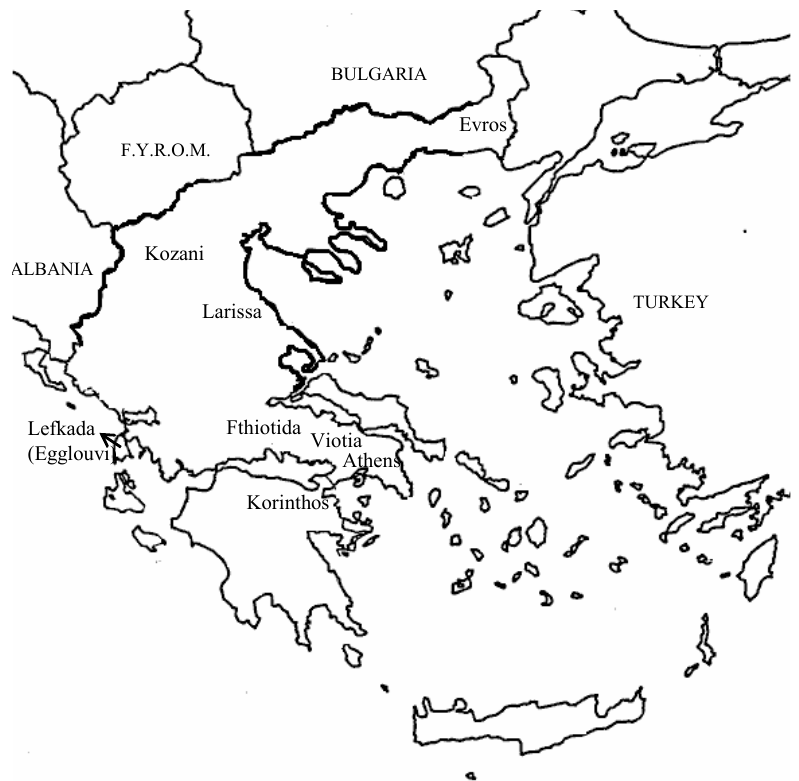
Figure 1. Surveyed areas of lentil fields in